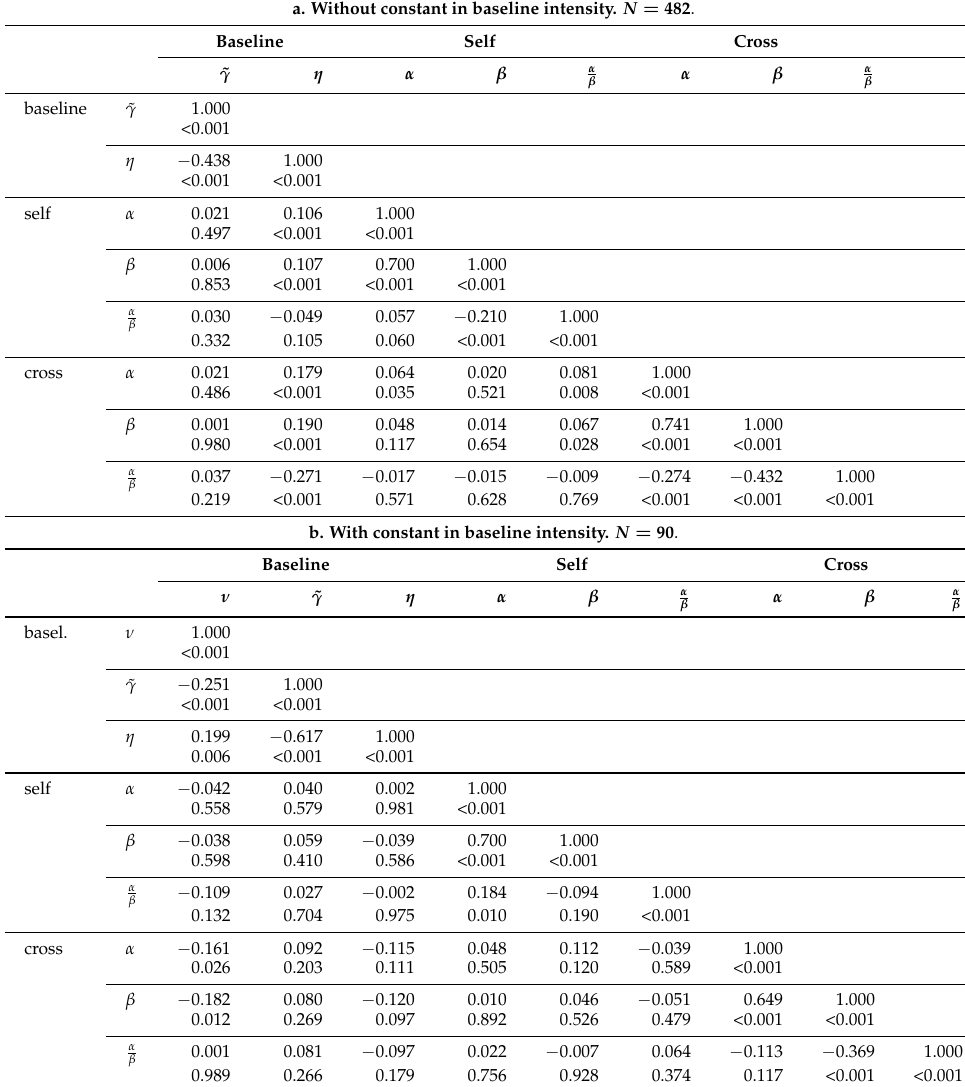
Table 7. Kendall’s taus and associated p -values for pairs of parameters of the models with self- and cross-excitation. a. Without constant in baseline intensity. N = 482